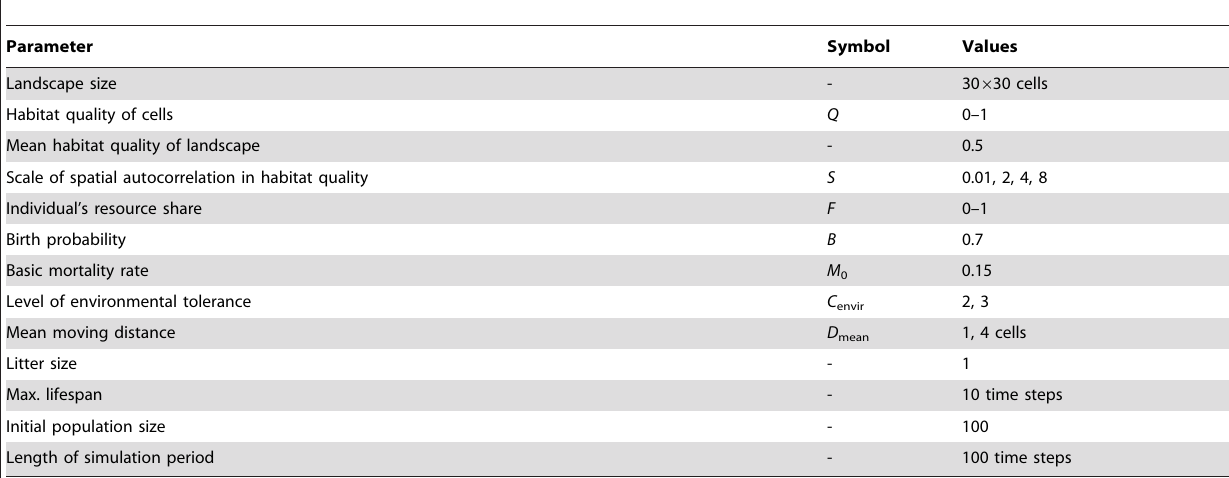
Table 1. Variables, parameters, and initial conditions used in the model.